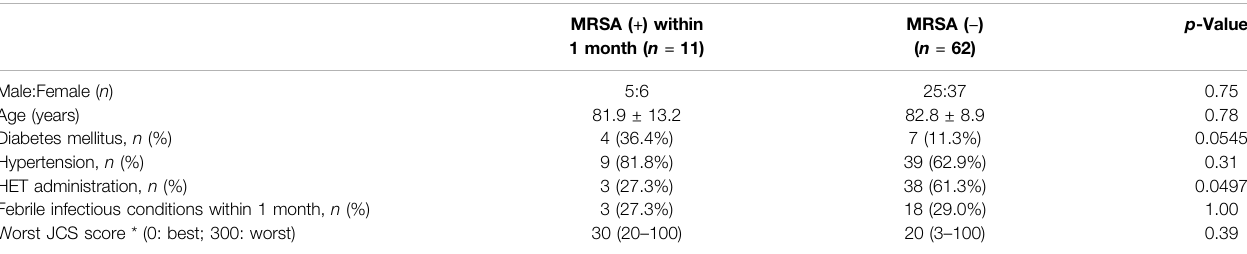
TABLE 2 | Patients ’ characteristics strati fi ed by MRSA colonization status in the fi rst month.